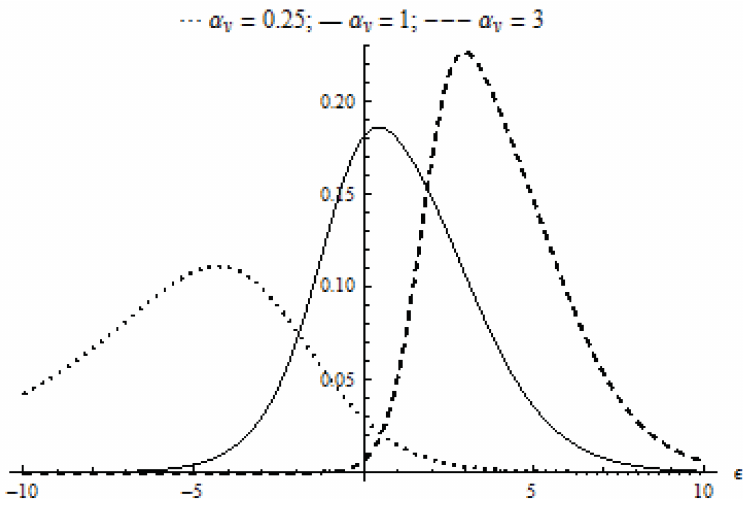
Figure 1. Density function of (cid:101) of a cost frontier with δ u = δ v = 1 and θ = 1 ( α v ranges between 0.25 and